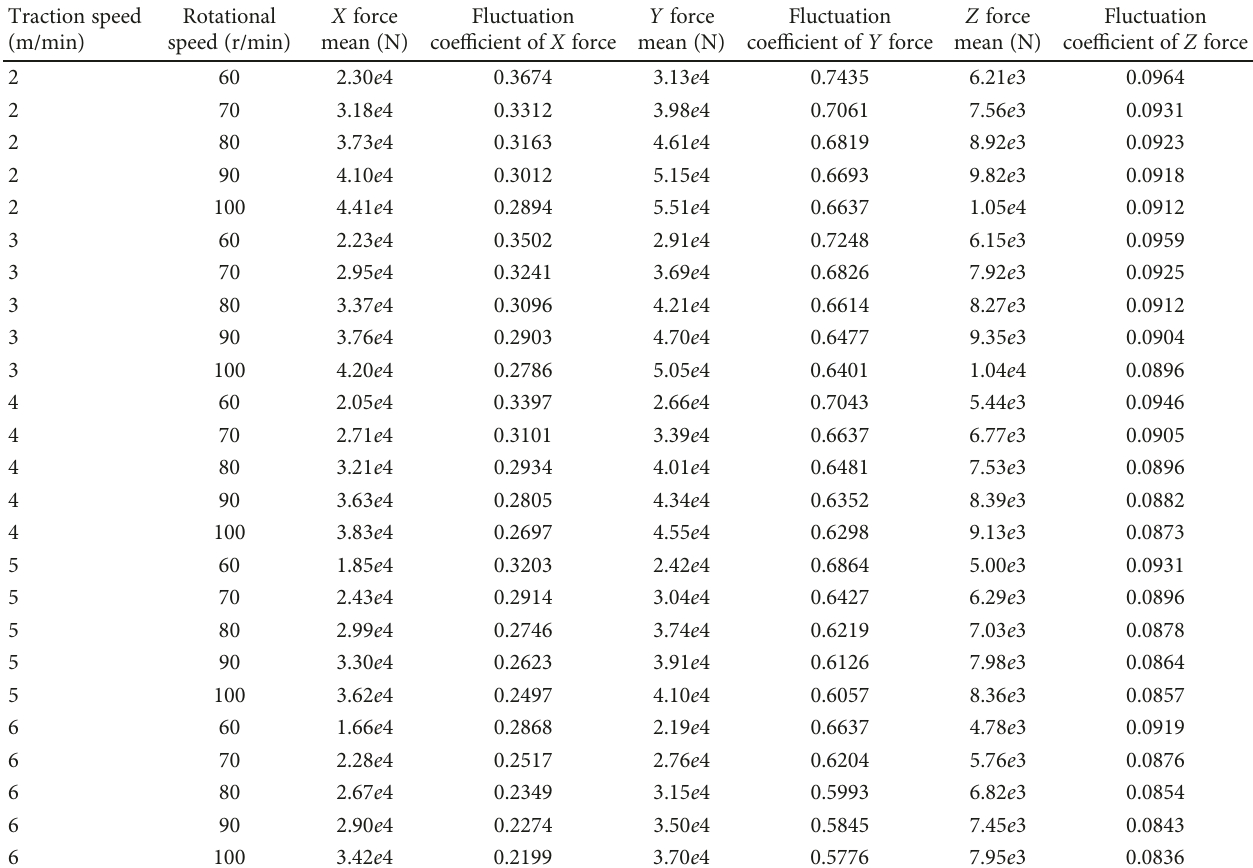
(b) The triaxial force of the drum Figure 8: The force of the spiral drum. Table 5: Simulation results of the drum ’ s triaxial